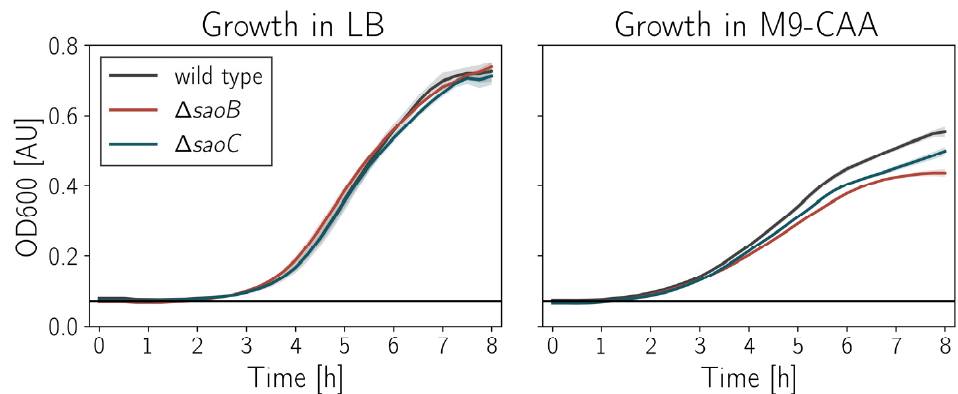
Figure 5. Growth dynamics of RN4220 strain knockout mutants of saoABC operon genes. In rich media there is not any difference in growth dynamics (plot on the left). However, in less optimal M9-CAA, Δ saoB and Δ saoC manifest slower growth and reach lower densities by around 20 and 10%, respectively, when compared to wild type RN4220 (plot on the right). The standard deviation of measurements ( n = 3) is depicted as shaded bands.